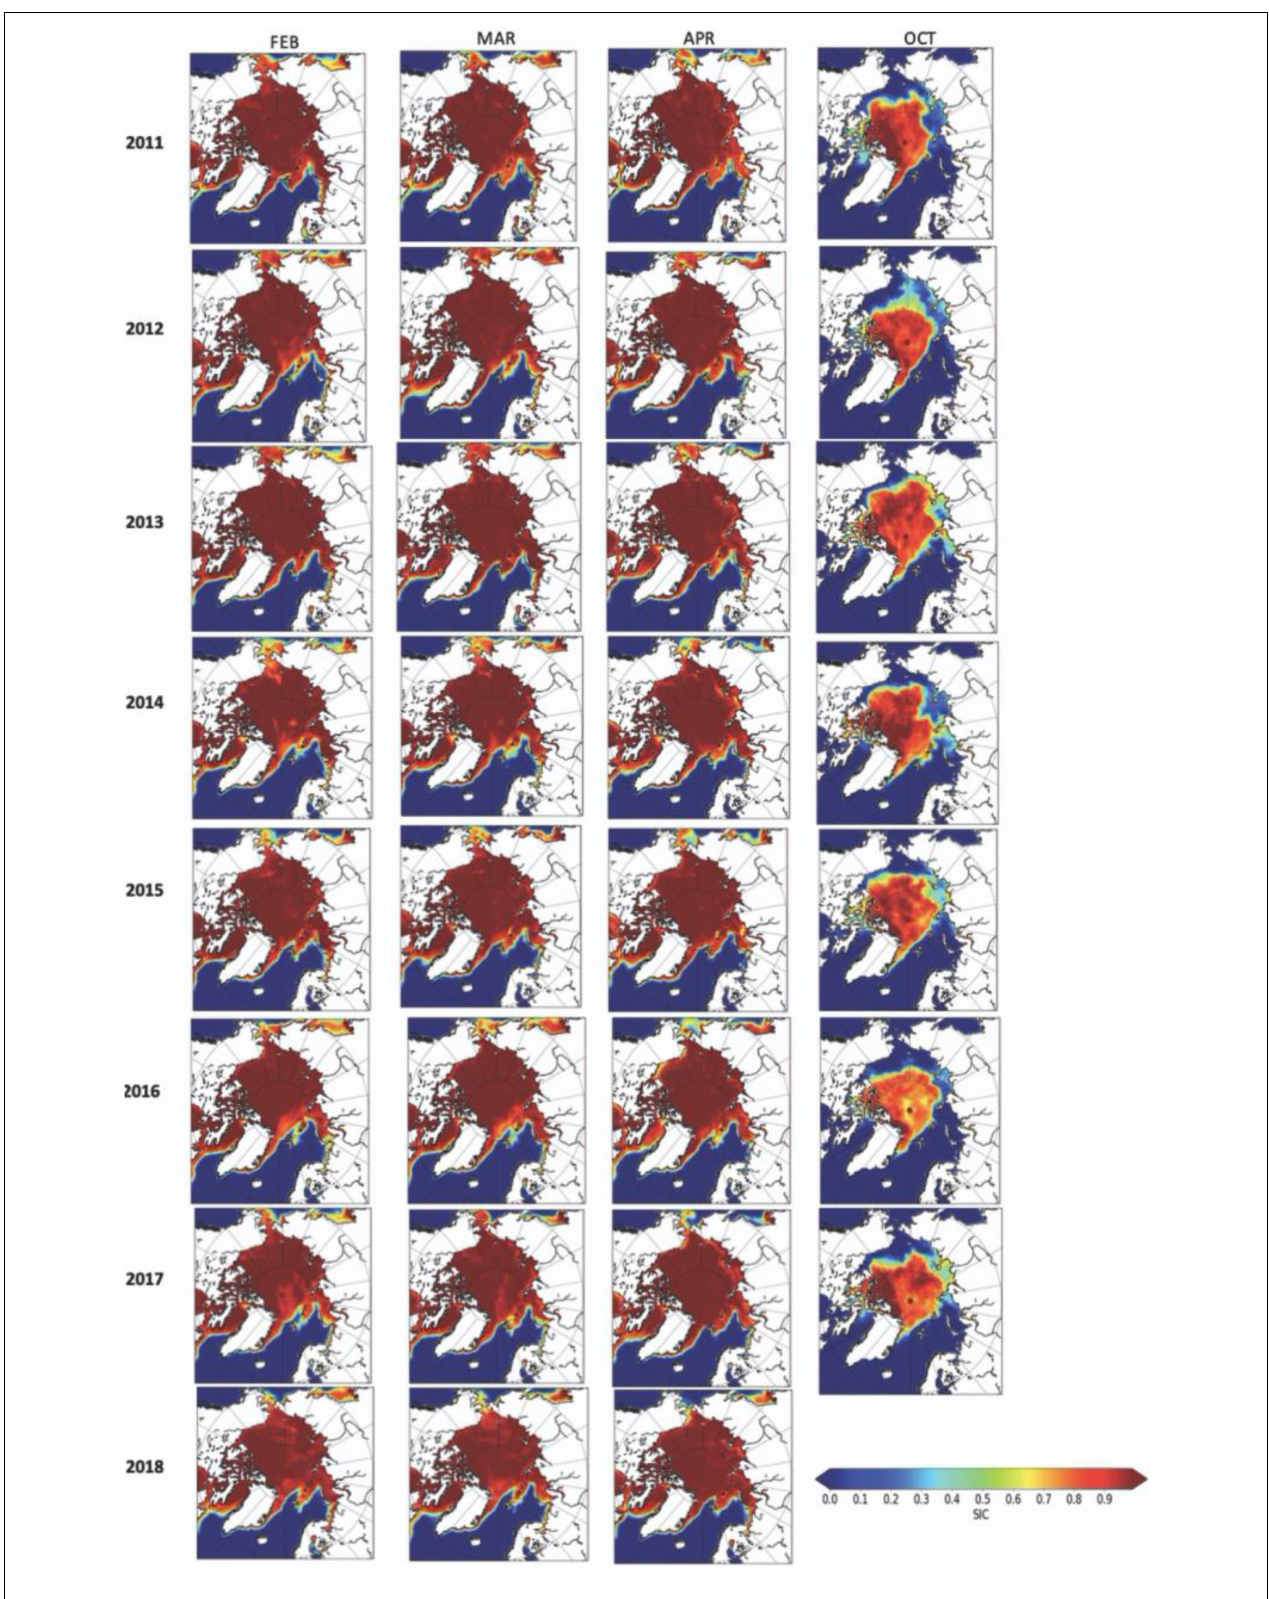
FIGURE 7 | Summary of the monthly mean sea ice concentration for all months and all years from February 2011 to April 2018.